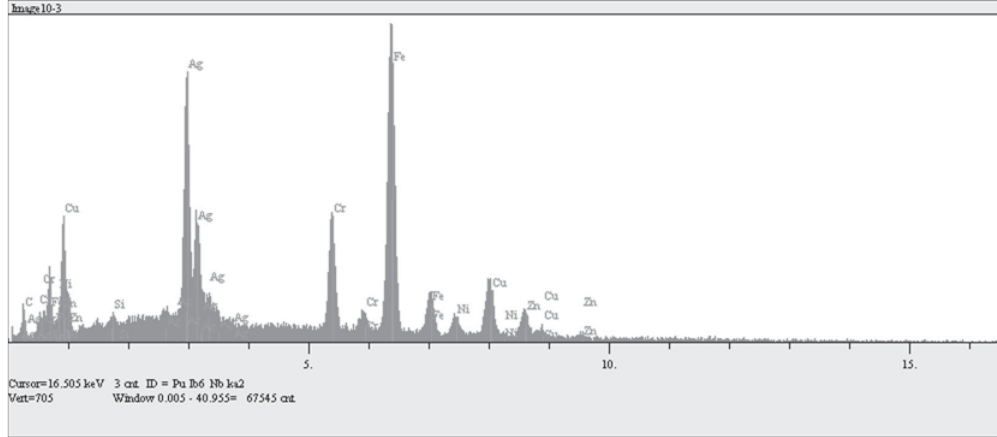
Figure 4- Quantitative reading of the composition of the stainless steel wire showing absence of